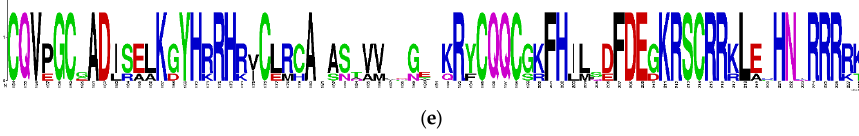
Figure 3. Conserved amino acid motifs in the SBP domain of the PgSPL proteins in ginseng. ( a ) Sequence logo of SBP domain of all SPL protein. ( b ) Sequence logo of SBP domain of A1 group. ( c ) Sequence logo of SBP domain of A2 group. ( d ) Sequence logo of SBP domain of B1 group. ( e ) Sequence logo of SBP domain of B2 group.